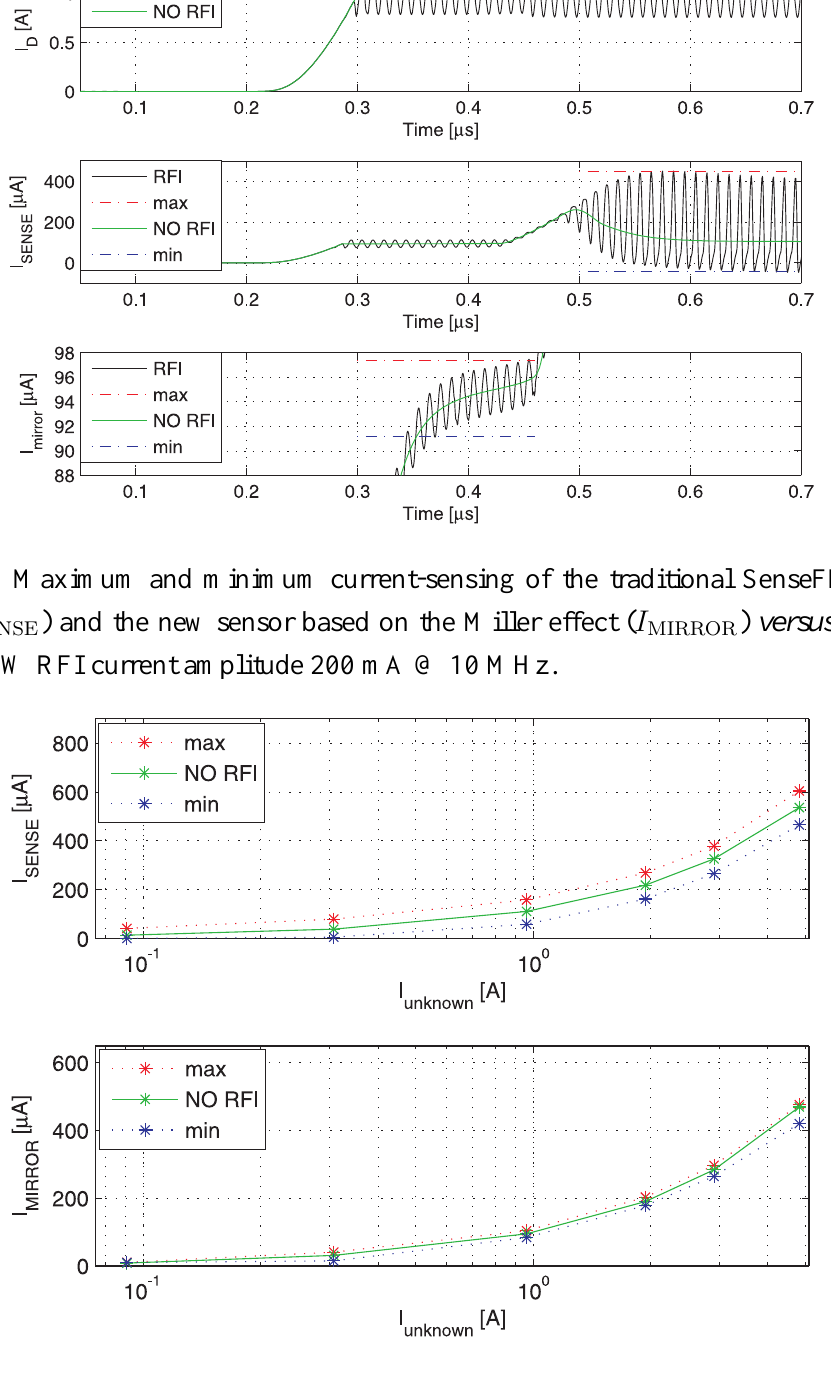
Figure 9. Switching transient traces of a Power MOSFET ( V currents provided by a traditional SenseFET sensor ( I the Miller effect ( I ). CW RFI current amplitude 200 mA @ 100 MHz superimposed MIRROR on the drain current.